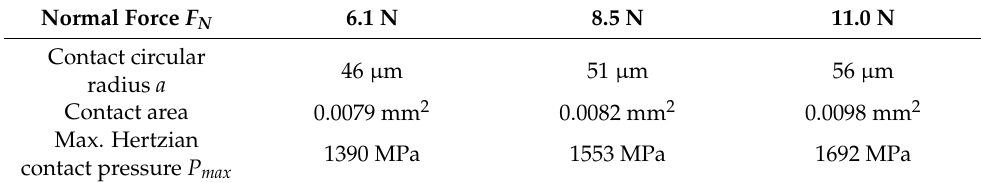
Table 3. Contact pressures calculated using Hertzian